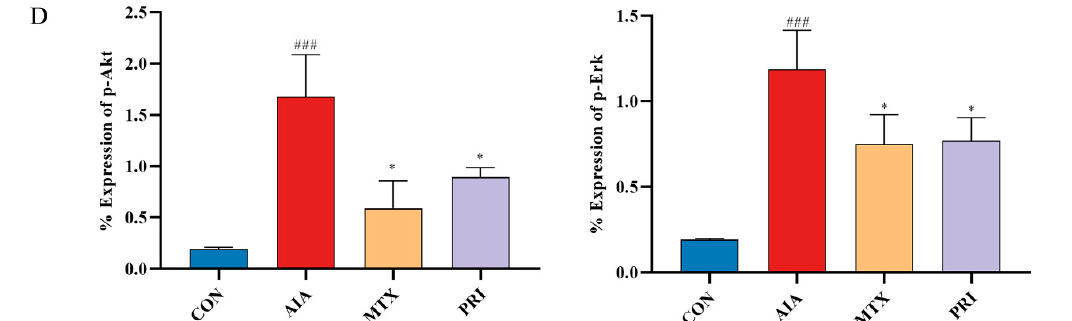
Figure 6. Typical photos of PRI effects on right hind paws of rats ( A ), histopathological changes in ankle joints ( B , ×100, HE staining) and the immunohistochemical expression of anti-p-Akt and anti- anti-p-Erk antibodies in ankle joints ( C , × 400, D ), * p < 0.05 compared with AIA group, ### p < p-Erk antibodies in ankle joints ( C , ×400, D ), * p < 0.05 compared with AIA group, ### p < 0.001 compared with CON group.